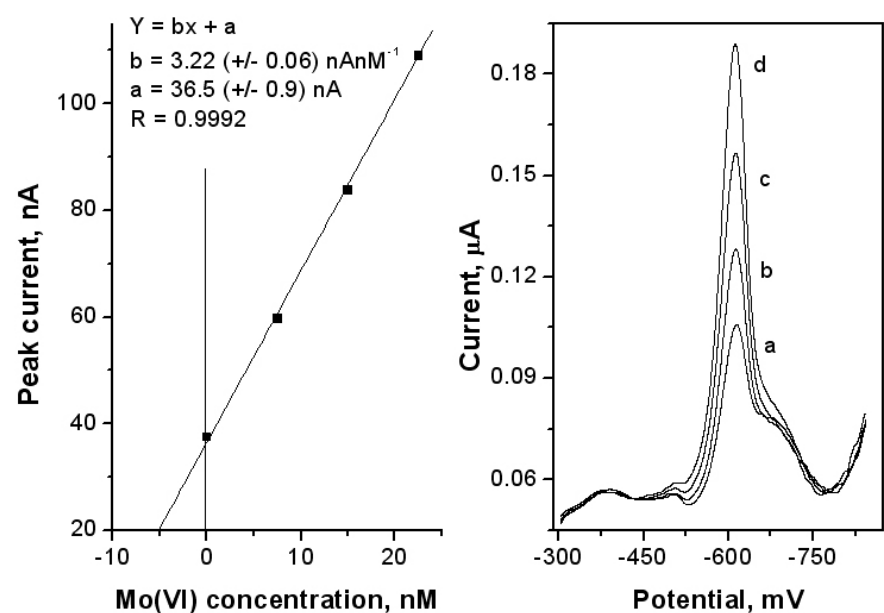
Figure 1. The DP AdSV molybdenum(VI) calibration curve and obtained voltammograms for scleroderma citrinum sample and (a) - 0; (b) - 7.5; (c) - 15; (d) - 22.5 nM of Mo(VI) in 100 µM chloranilic acid (pH of base electrolyte 2.5) obtained for pre-concentration time 20 s. Pre- concentration potential 0.0 mV, stirring rate during preconcentration step 500